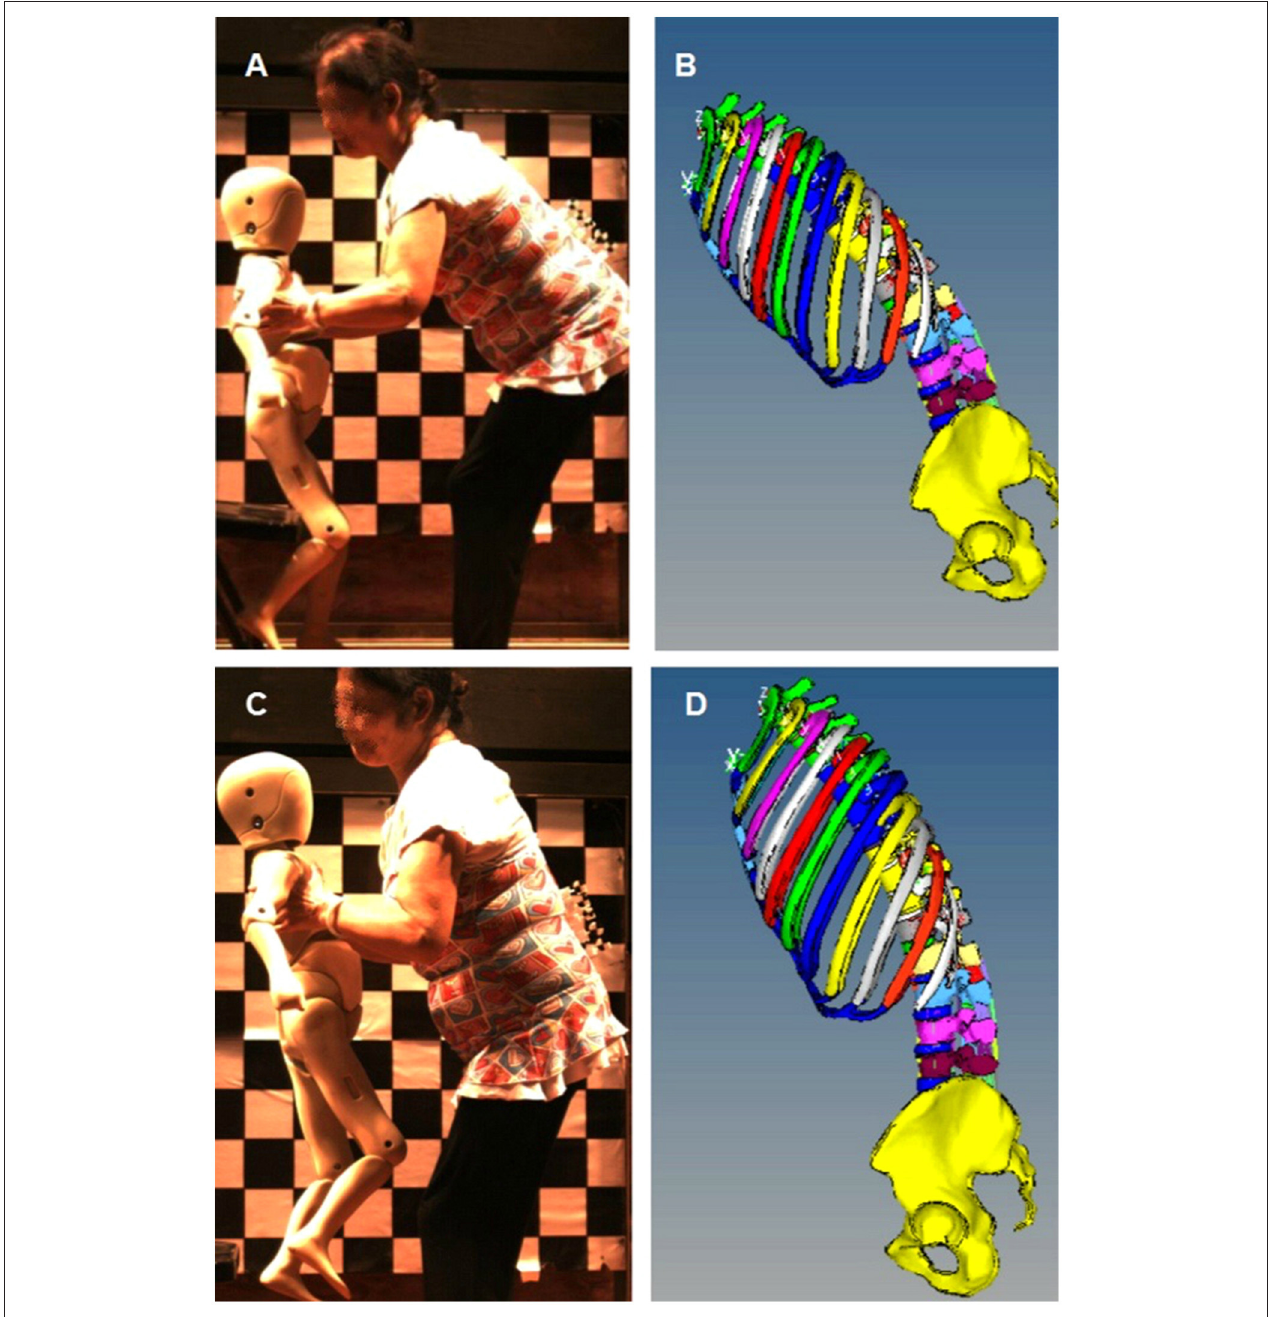
FIGURE 2 | FEM mechanical simulation of volunteers lifting dummy. (A) Bending posture with lifting 3-year-old dummy, (B) Lumbar FEM adjusted posture according (A,C) Upright posture with lifting 3-year-old dummy, (D) Lumbar FEM adjusted posture according (C) .